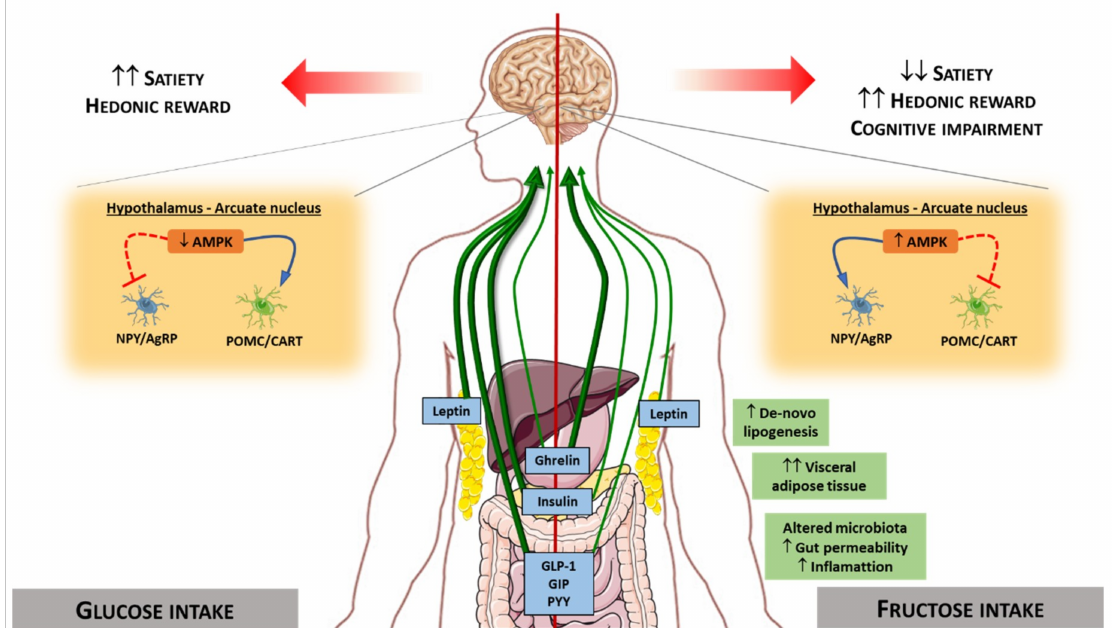
Figure 5. Peripheral and central e ff ects of glucose and fructose on food intake. Upon nutrient ingestion, glucose triggers the secretion of anorexigenic peptides such as leptin, insulin, GLP-1, GIP, PYY, and blocks the secretion of the orexigenic hormone ghrelin. These peptides will induce AMPK inhibition, which will lead to the stimulation of POMC / CART neurons, contributing to satiety response. However, upon fructose consumption, the secretion of anorexigenic peptides is decreased, as well as the repression of ghrelin secretion. These facts will cause the increase in AMPK activity, which will lead to the repression of POMC / CART neurons and the activation of NPY / AgRP, leading to reduced satiety suppression, as well as higher hedonic reward to food and increasing food intake, in addition to playing a possible role in cognitive functions. This figure was created using Servier Medical